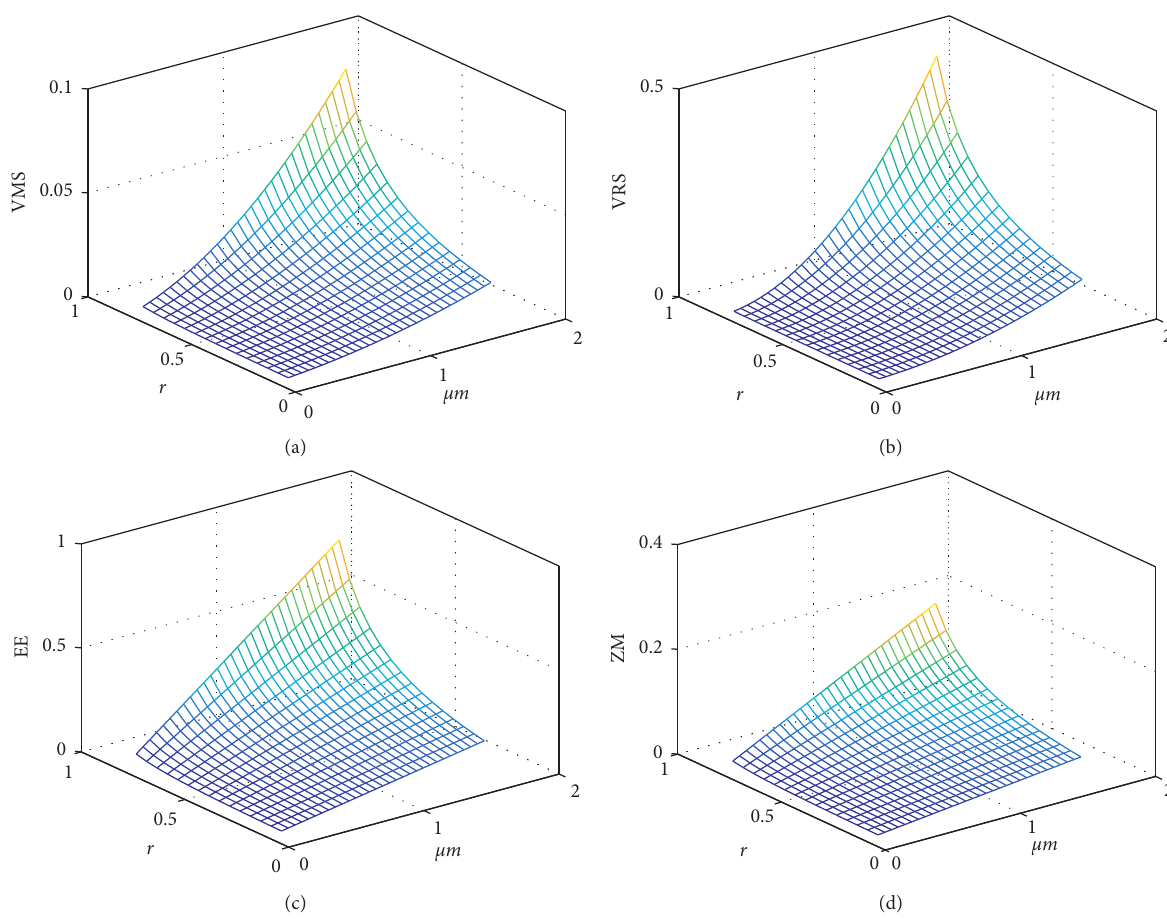
Figure 5: Sensitivity analysis of emission-reduction efforts, cost coefficient, and cost subsidy